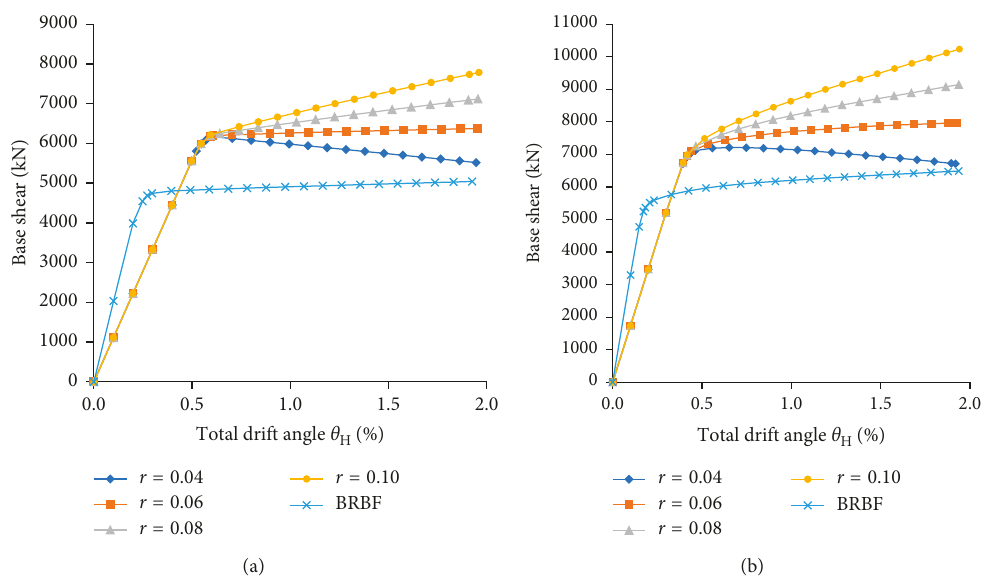
Figure 13: The effects of r on the base shear response of 16-story SC-TOBFs: (a) LD-1 and (b) LD-2.